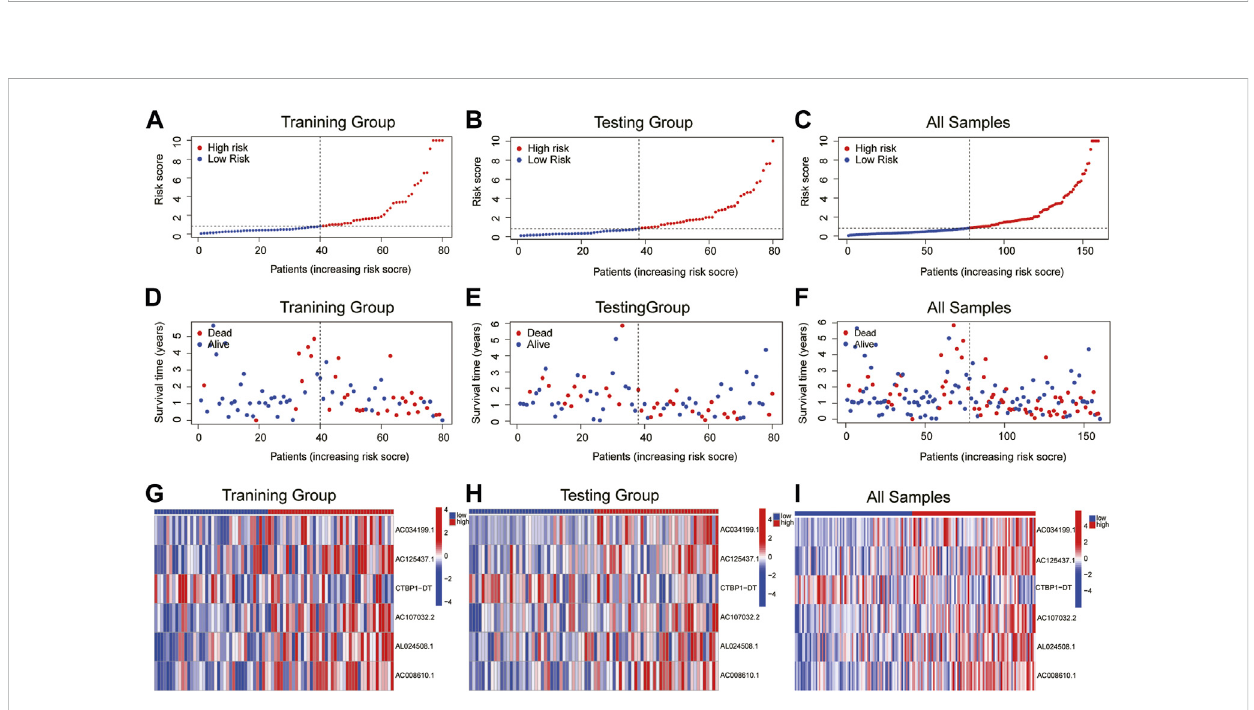
FIGURE 3 The distribution of OS risk scores and heat maps of 6 lncRNAs. (A – C) The distribution of OS risk scores. (D – F) Survival time and status. (G – I) Heat maps of 6 lncRNA expressions.